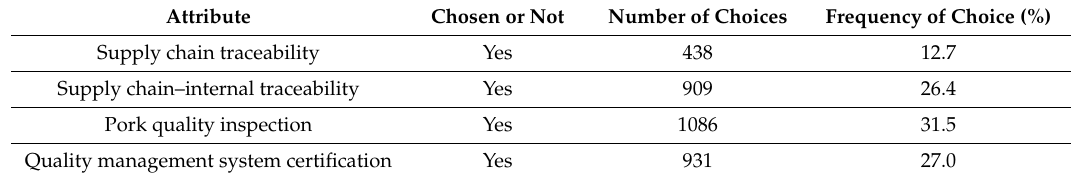
Table 7. Number and frequency of the choice for each attribute in the menu-based choice